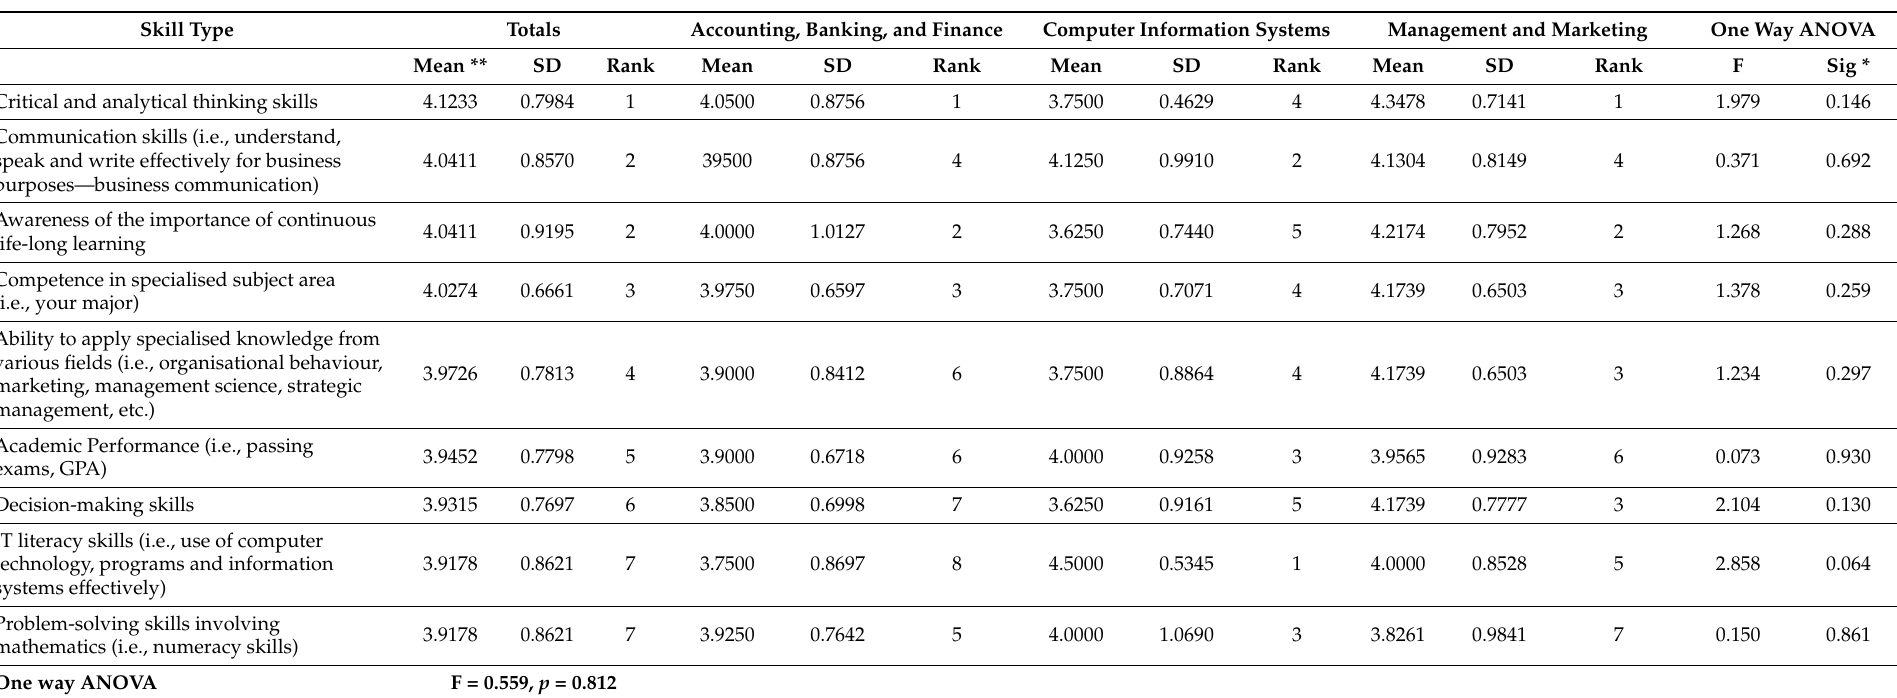
Table 4. Academic